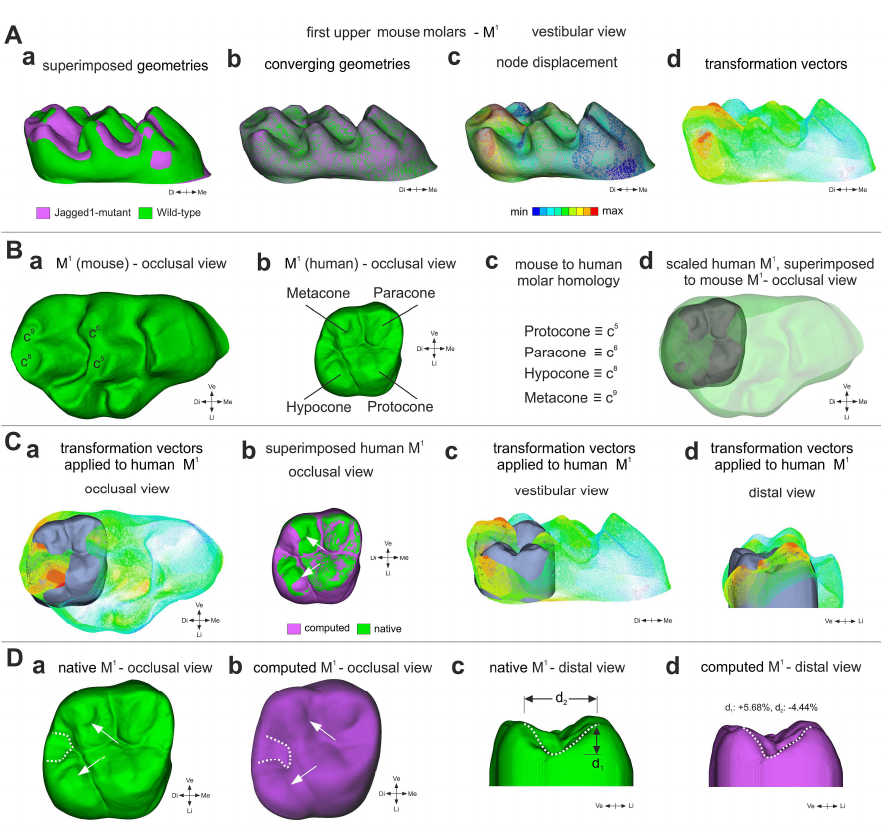
Figure 5. Prediction of tooth crown morphologies in humans carrying Jagged1 mutations. ( A ) Compared morphologies of WT and K14Cre;Jagged1 fl/fl M 1 . ( Aa ) Pre-processing (scaling, positioning and alignment) of proxy geometries, illustrating the affinity of source and target surfaces of rodent M 1 . Green color represents WT teeth, violet color indicated mutant teeth. ( Ab ) Conversion of the morphed WT M 1 , approximating the K14Cre;Jagged1 fl/fl M 1 geometry. ( Ac ) Magnitude of nodes movement required for the approximation of the WT M 1 geometry to the K14Cre;Jagged1 fl/fl M 1 geometry. ( Ad ) Indicative view of the transformation vectors from WT M 1 to K14Cre;Jagged1 fl/fl M 1 . ( B ) Tooth homology between mouse and human M 1 molars. ( Ba ) Occlusal view of mouse WT M 1 indicating the comparable to the human M 1 cusps. ( Bb ) Occlusal view of human M 1 indicating the four cusps. ( Bc ) Nomenclature homologation in-between the human M 1 and mouse M 1 cusps. ( Bd ) Scaled human M 1 superimposed on WT mouse M 1 . ( C ) Transformation vectors of the morphing process repre- senting the magnitude of the source nodes’ (WT M 1 ) movement during their approximation of the K14Cre;Jagged1 fl/fl M 1 geometry. ( Ca , c , d ) Transformation vectors superimposed on human M 1 . ( Cb ) Superimposed native (green color) and computed (violet color) human M 1 . ( D ) Comparison of the native human M 1 and predicted human mutant M 1 . ( Da , b ) Native (green color in ( Da )) and computed (violet color in ( Db )) human M 1 indicating statistically significant changes in cusps (arrows) and the inter-cusp space (dotted lines). Occlusal view. ( Dc , d ) Native (green color in ( Dc )) and computed (violet color in ( Dd )) human M 1 showing a notable deeper and narrower profile of the distal ridge in mutant teeth (dotted lines in ( Dd )) compared to the native teeth (dotted lines in ( Dc )). Distal